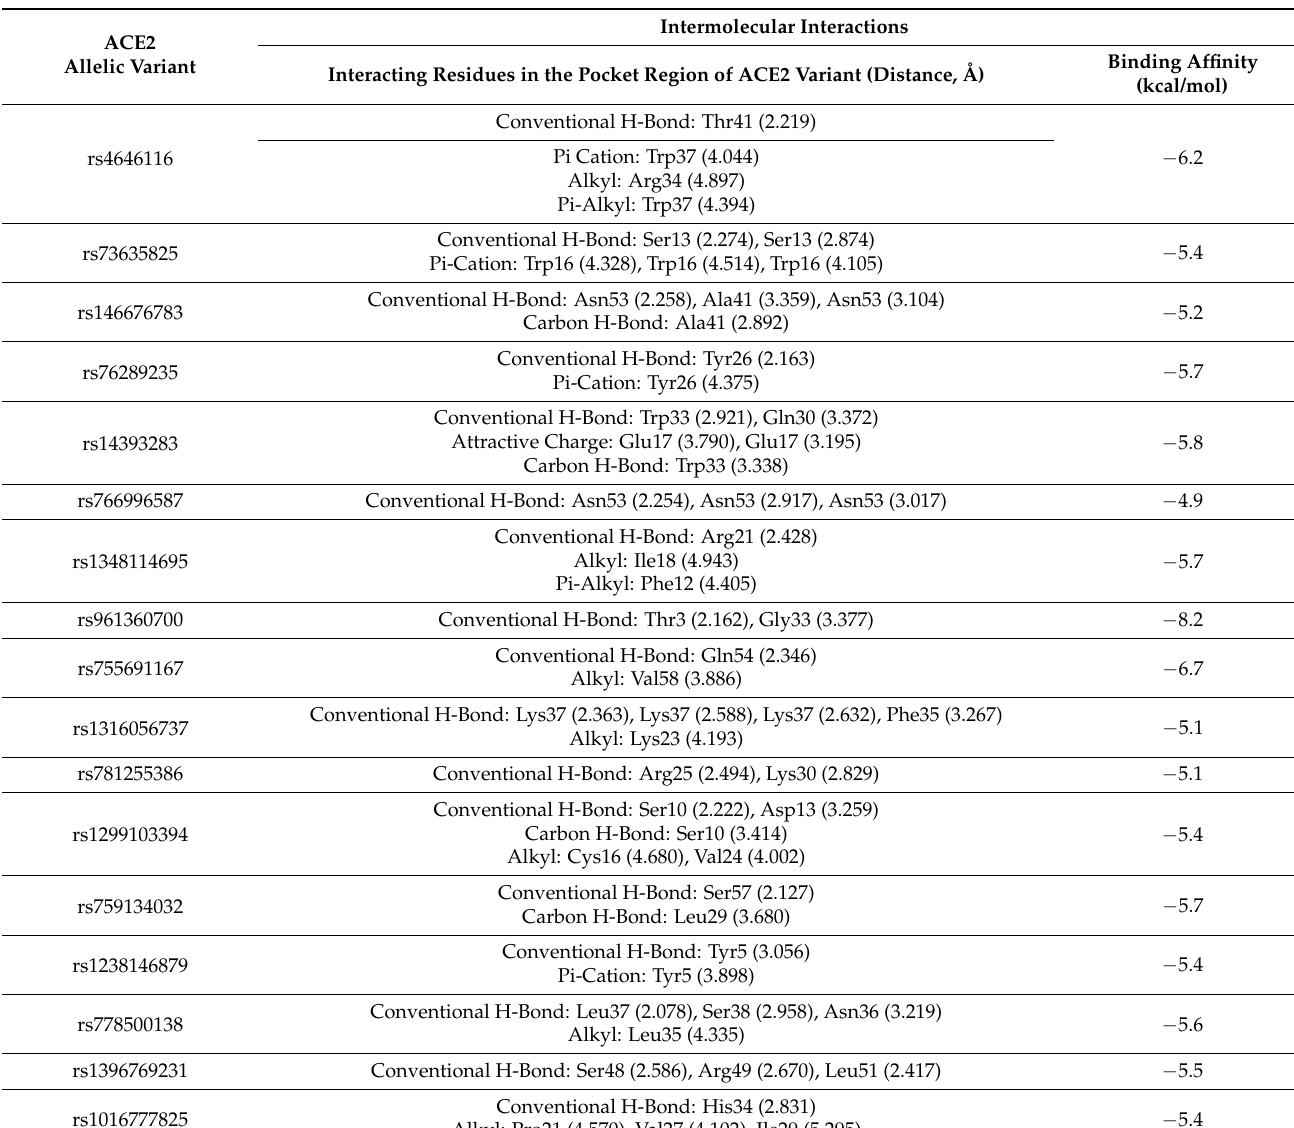
Table 3. Binding affinity, conventional hydrogen bonds, and interacting residues of the different ACE2 domains reported to bind with the coronavirus spike protein and